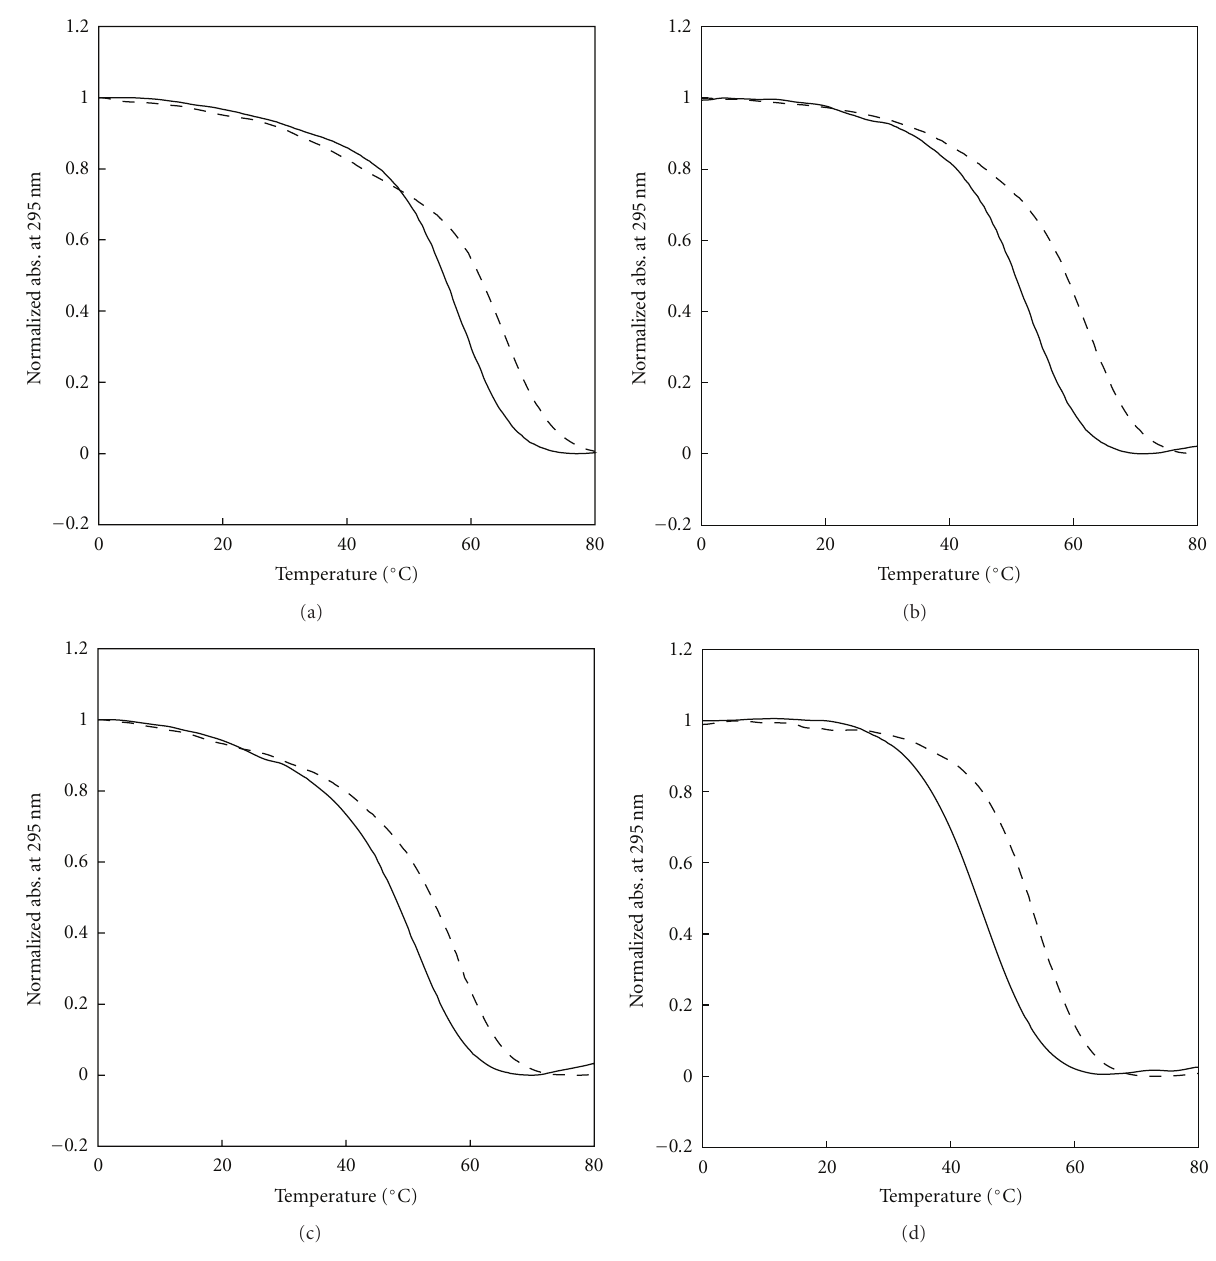
Figure 3: Normalized UV melting curves for 20 µ M AP-0 (a), AP-1 (b), AP-2 (c), and AP-3 (d) in a bu ff er of 100mM NaCl, 50mM Tris-HCl (pH 7.0), and 1mM Na 2 EDTA at 0wt% (0molL − 1 ) (solid line) and 40wt% (2molL − 1 ) (dashed line)